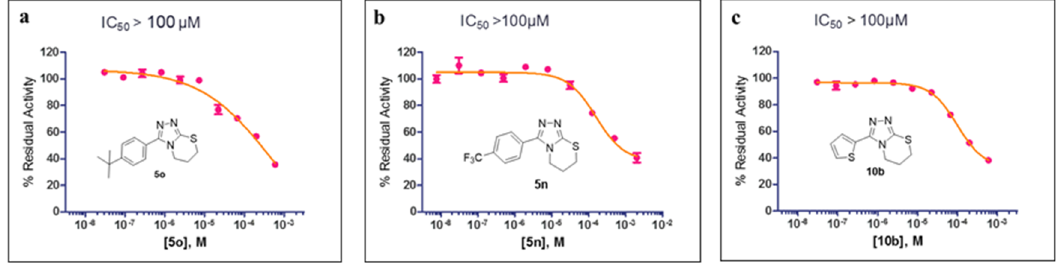
Figure 4. The IC 50 curves of 5o ( a ) against IMP-1, 5n ( b ) against VIM-1, and 10b ( c ) against IMP-1.